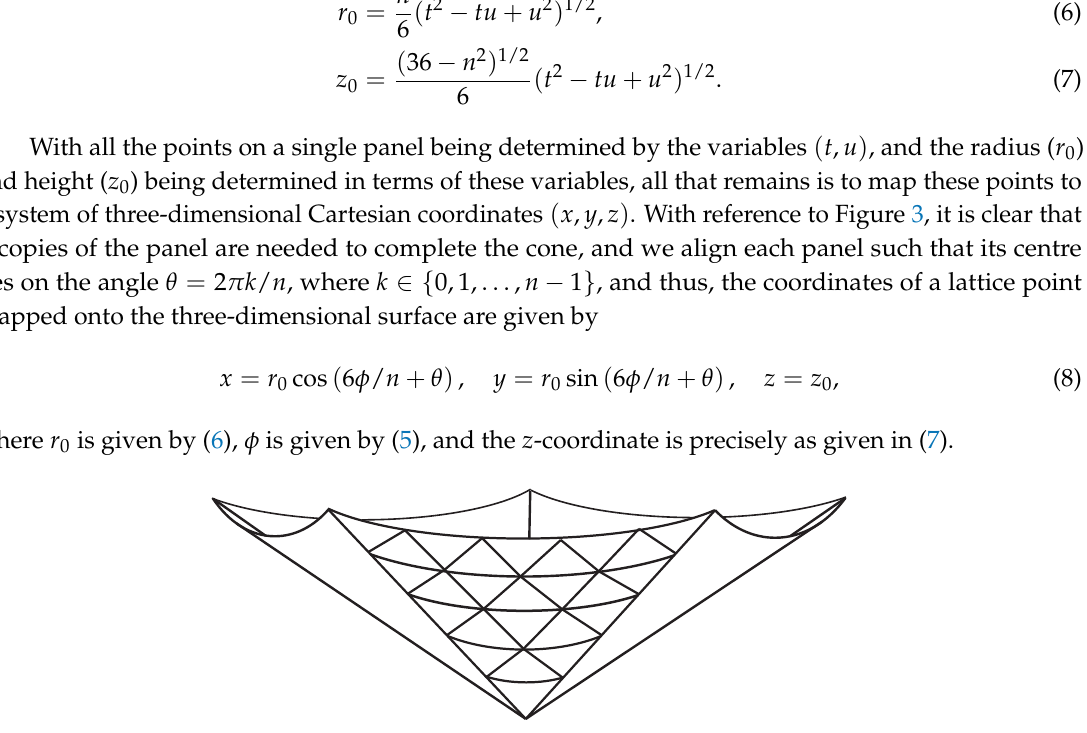
Figure 3. Example of a cone comprising five panels (triangular tessellation is shown on only one panel).